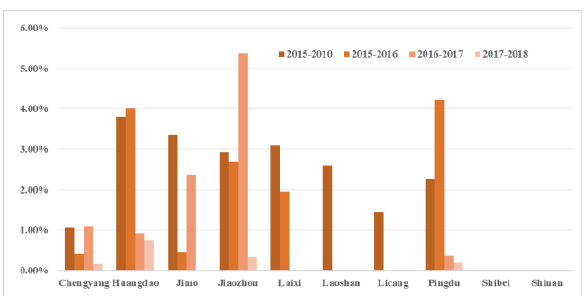
Figure 1 . Urban land area of different districts and county-level cities in Qingdao from 2010 to 2018.